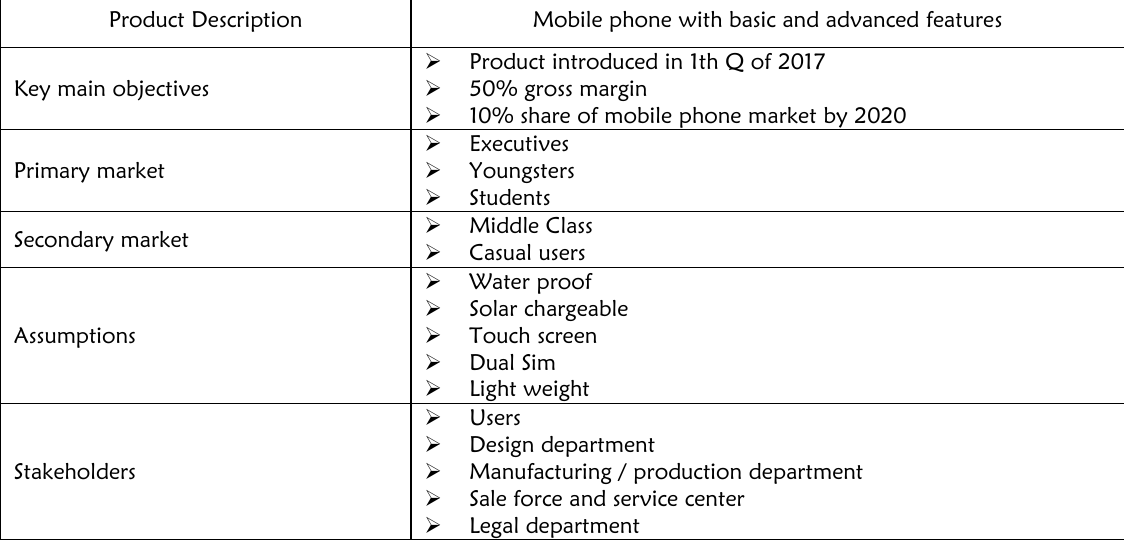
Table 1: Mission statement for the mobile phone.